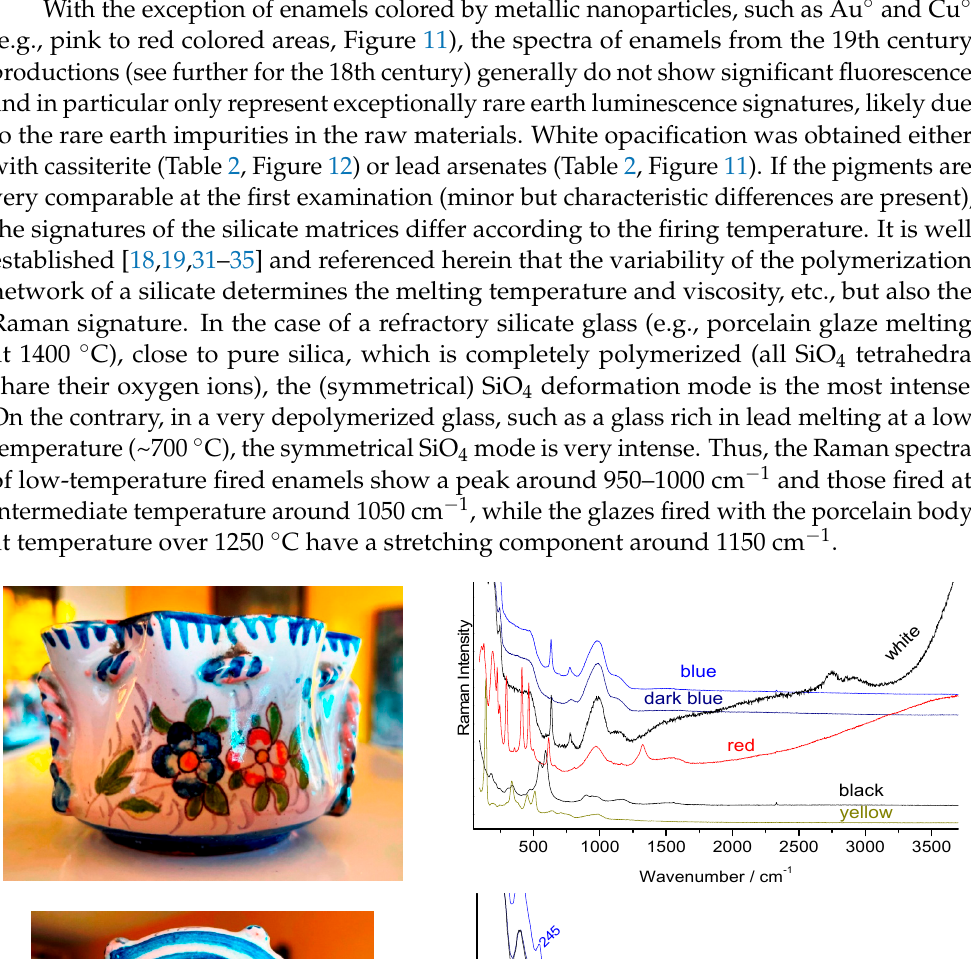
Figure 12. Representative Raman spectra recorded with 514.5 nm excitation on 19th-century Nevers faience (Montagnon factory, Nevers); colored areas examined are given. Band with a * arise from the filter.